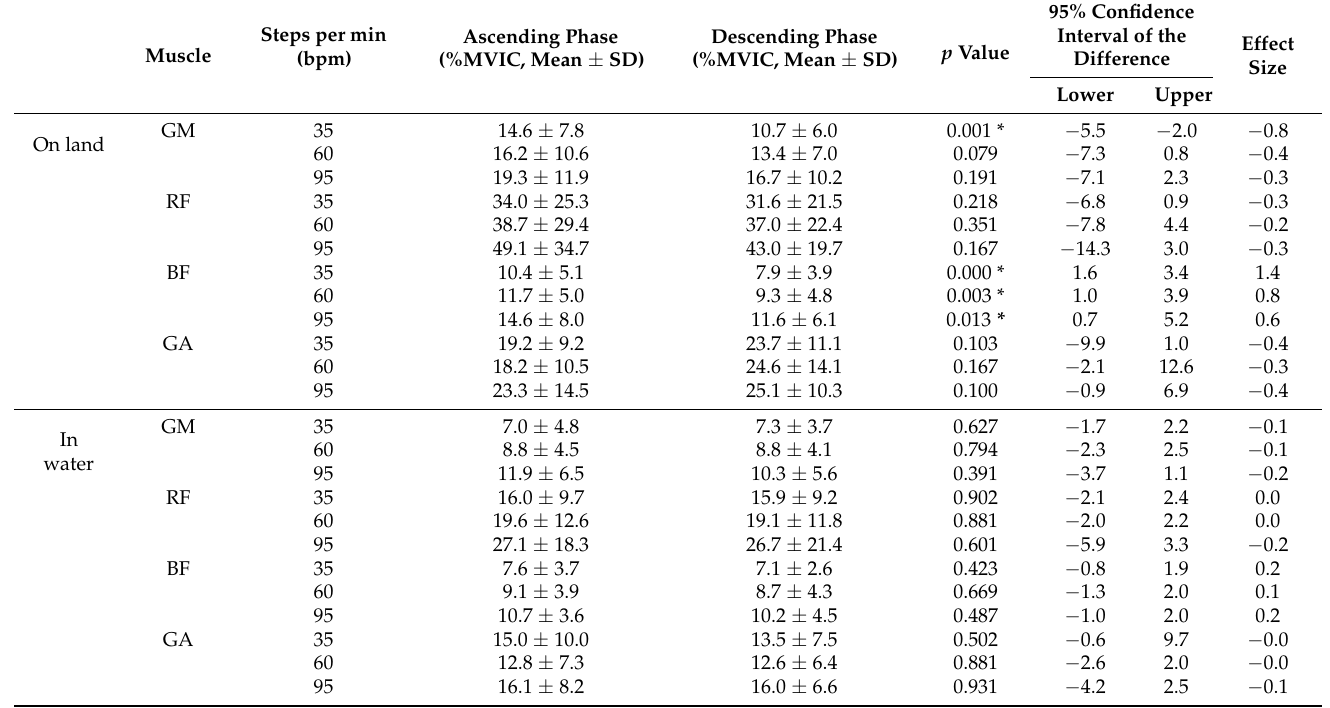
Table 3. The comparison of tested muscle activation at different phases (GM = gluteus